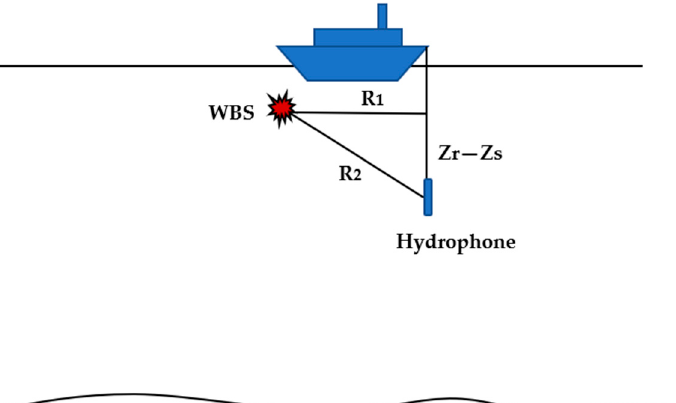
Figure 4. Configuration of the source level calibration.